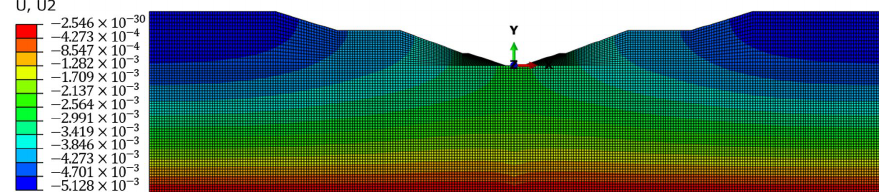
Figure 14. Canal settlement nephogram when t = 10 years.